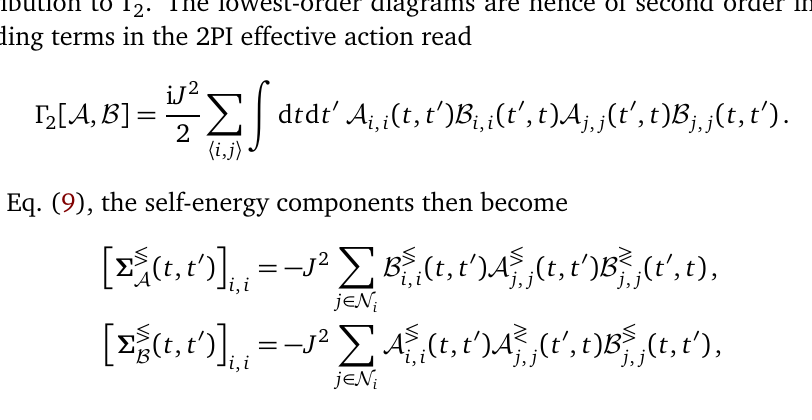
Figure 7: Spectral function A bosonic mixture Eq. (51) at centre-of-mass time J T = 2.5 (s. Appendix A). Dashed lines again show numerically exact results (cf. Fig.